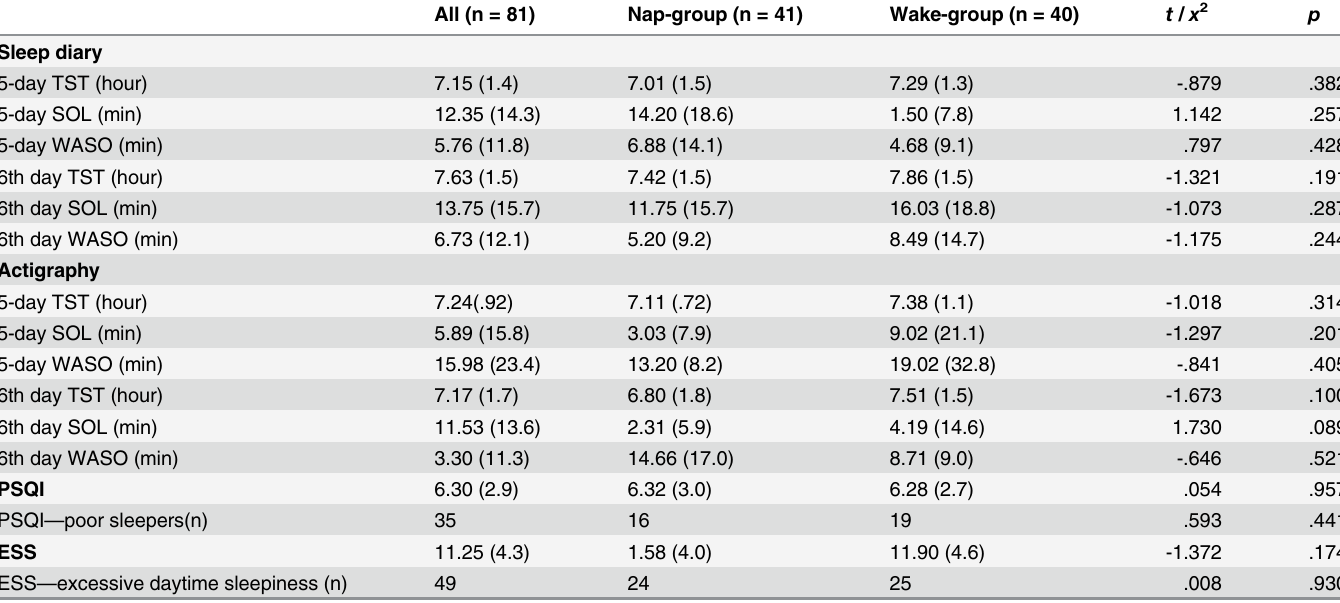
Descriptive information of the participants was reported in Table 1. The two groups did not significantly differ on age, sex, body mass index, p s > .05. There were also no significant differ- ences on the negative mood as measured by DASS, p s > .05. The sleep measures derived from sleep diary, actigraphy, PSQI and ESS revealed no signifi- cant differences between the groups, p s > .05 (Table 2). For total sleep time, both groups re- ported to have about 7 hours of sleep on average for the five days before the experimental session assessed by both sleep diary and actigraphy. About 43.2% of participants were classified as poor sleepers by PSQI, and 62.0% as having excessive daytime sleepiness by ESS in both Table 2. Sleep-wake patterns of the